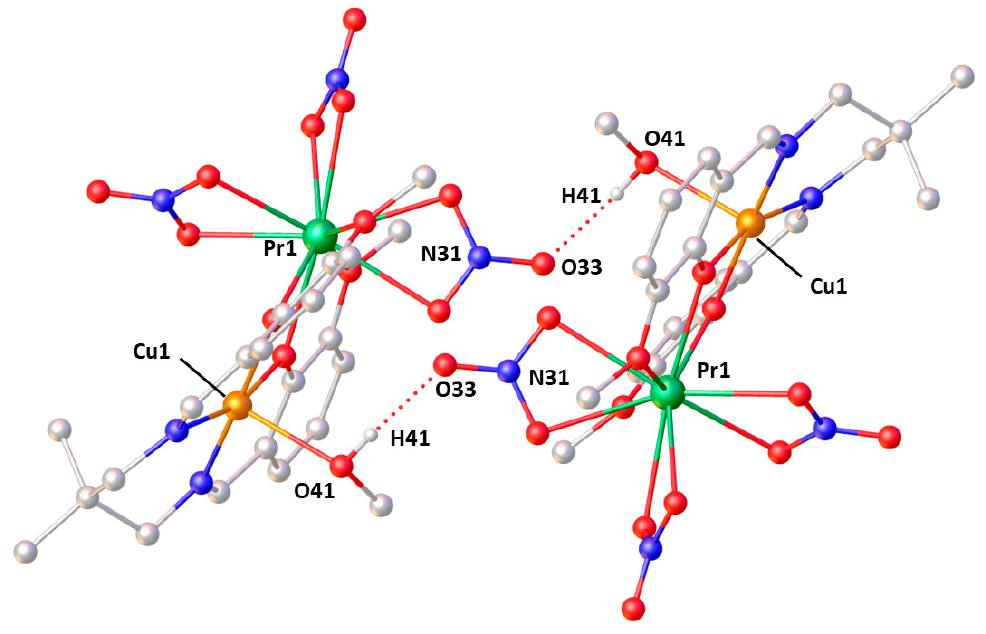
Figure 2. The dominant hydrogen-bonding interactions in 1-Pr . The same interactions occur in 1-Ce . All carbon-bound hydrogen atoms are omitted for